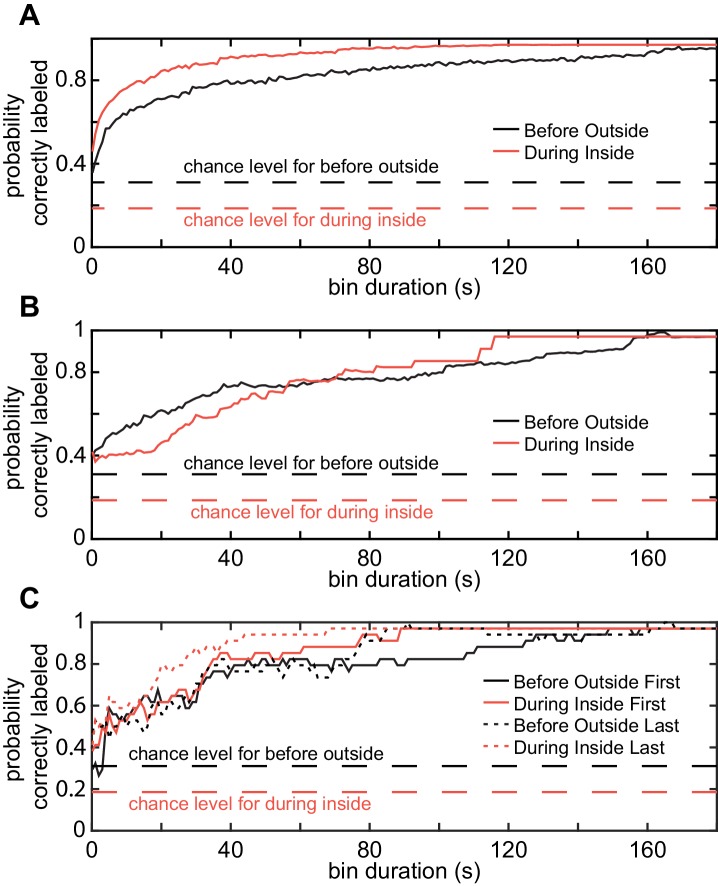
Cluster assignments are stable over time.The Euclidean distance between the HL state distribution for each time bin and each of the four centroids were calculated. ‘Correct label’ means that the orginial cluster was the closest. The three panels differed in how the bins were assembled. (A) Probability of assignment to the original cluster based on randomly selected sample. This analysis measures the extent to which subsampling is likely to result in flies in the same cluster. (B) Contigous tracks of given size anywhere in the track show similar assignment stability. (C) Same as C but for the bins at the start and end. Dashed lines represent random chance for before outside (black) and during inside (red).